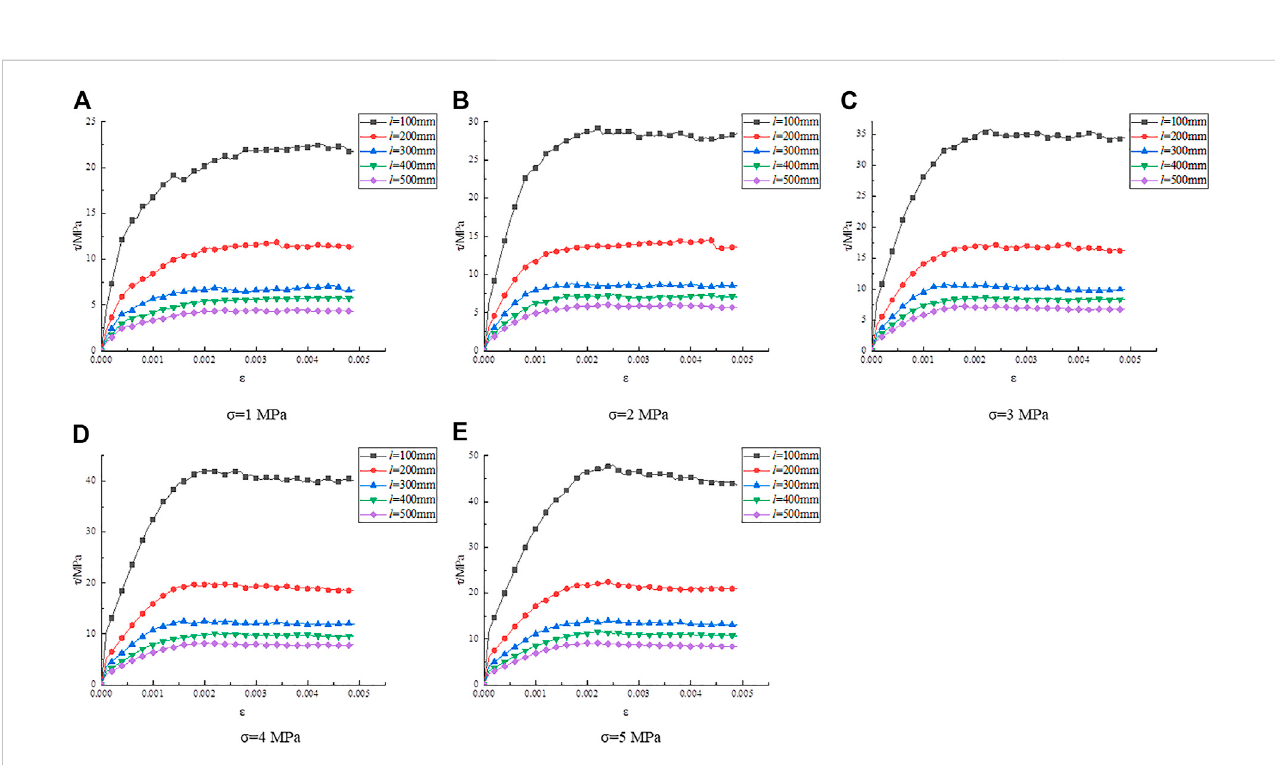
FIGURE 5 Stress – strain curves for different normal stress